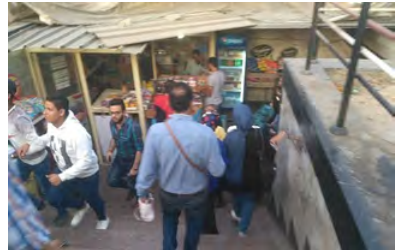
Figure 10. Extreme violation in the entrance of pedestrian pass tunnel (The researcher, 2017)